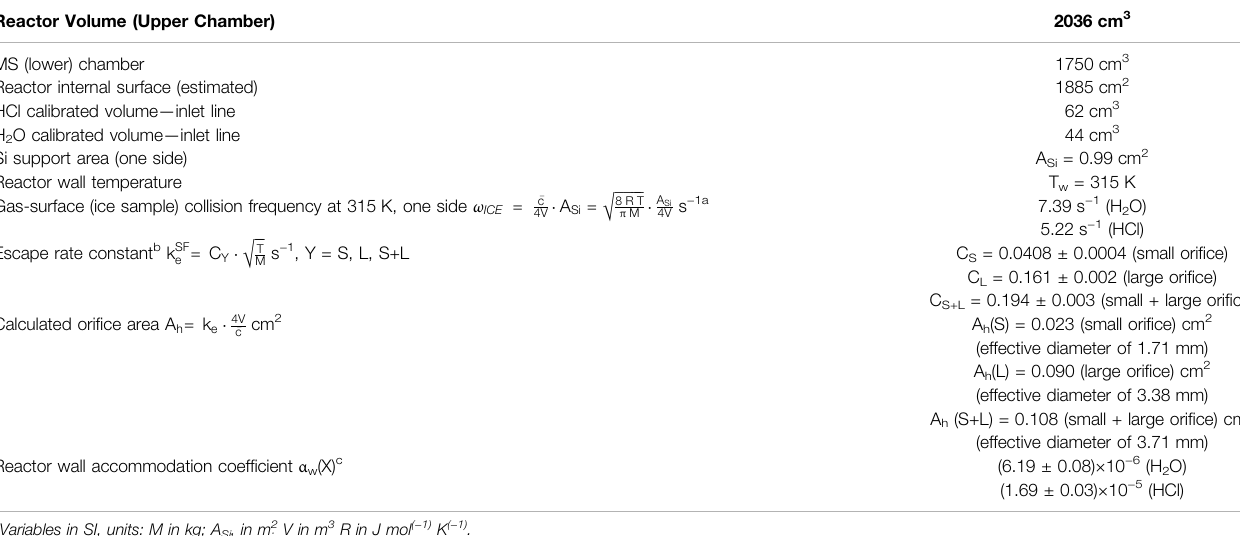
TABLE 5 | Relevant parameters for SFR (Iannarelli and Rossi,